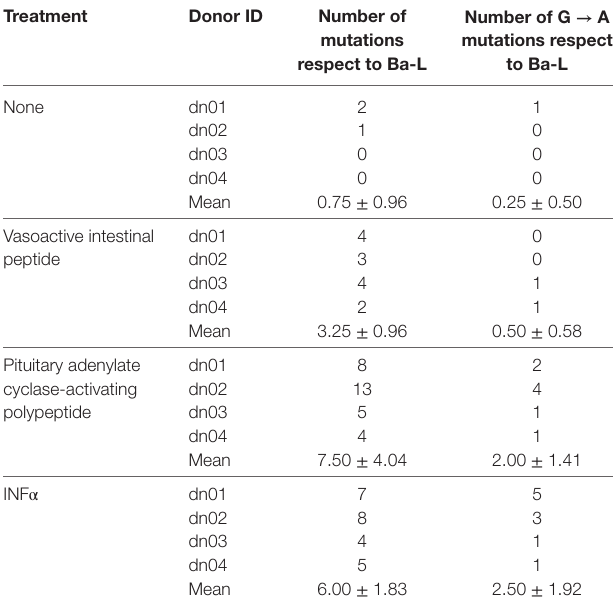
TaBle 1 | Description of total and specific G to A mutations identified in HIV-1 provirus from infected cells exposed to different treatments. Treatment Donor iD number of